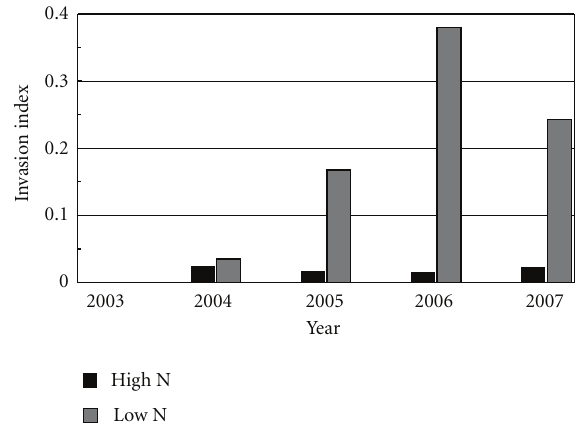
Figure 6: Mean invasion indices in pooled high- versus low-pooled nitrogen treatments by year. Note: the number of zero values precluded statistical